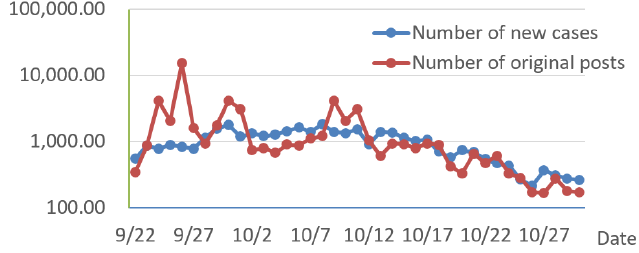
Figure 6. Trend in Guangdong province.